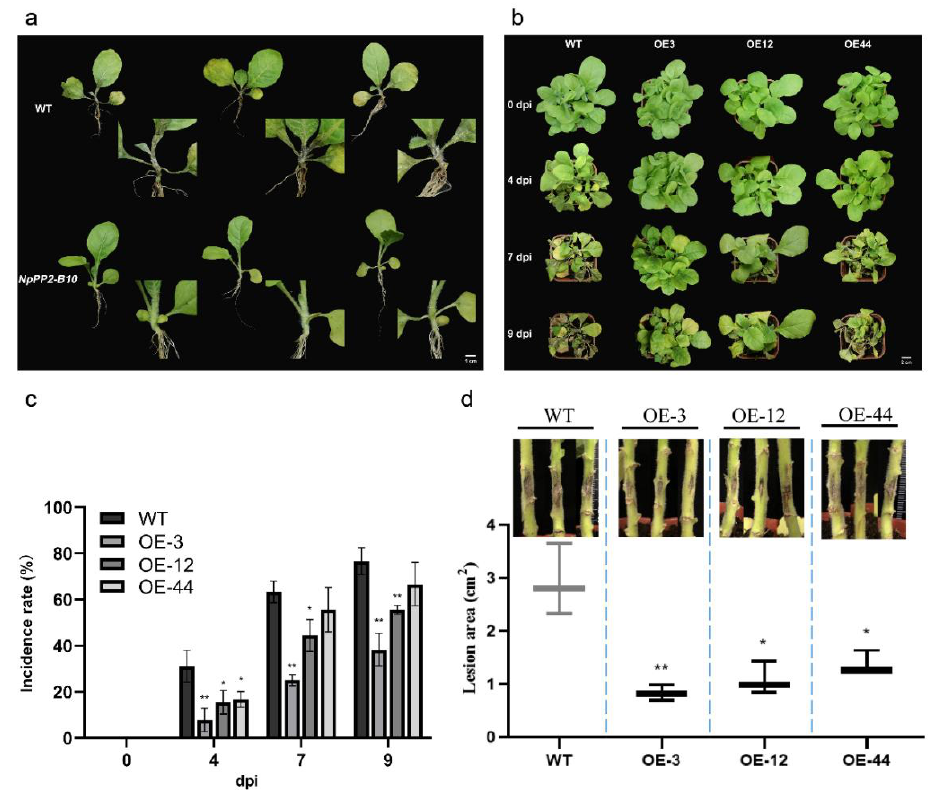
Figure 3. Phenotypes of NpPP2-B10 -OE lines and the WT after infection with P. nicotianae race 0. ( a ) Phenotype of roots of each line 3 days after infection. ( b ) Overall phenotype of each line from 0 to 9 days after infection. ( c ) Incidence rate of each line from 0 to 9 days after infection. ( d ) Phenotype and spot area on the stem of each line after infection. Asterisks denote significant differences (com- pared with the control group): * p < 0.05, ** p < 0.01, by Student’s t -test.